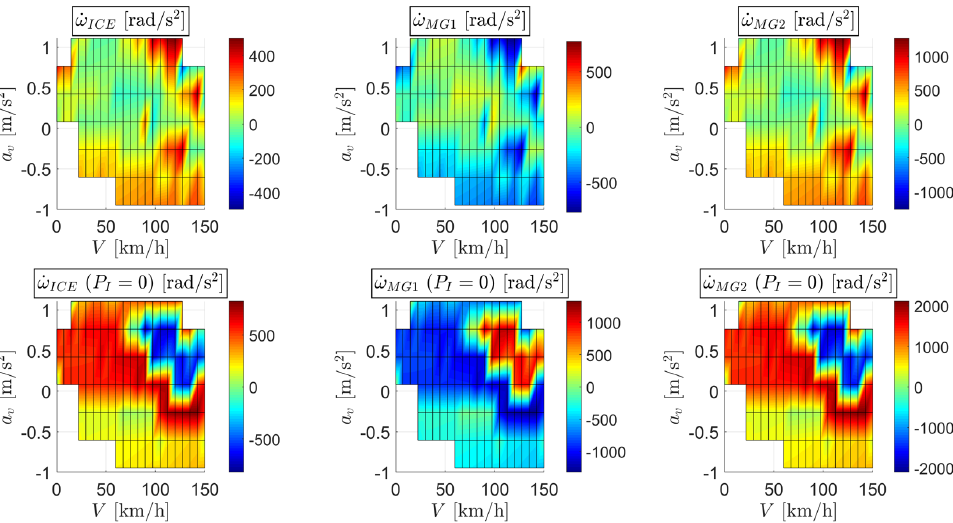
Figure 13. ICE ( left ), MG1 ( center ) and MG2 ( right ) angular accelerations to achieve the lower power-weighted efficiency with ( top ) and without ( bottom ) the activation of the penalty factor P I for the Compound Split mode and road slope α =